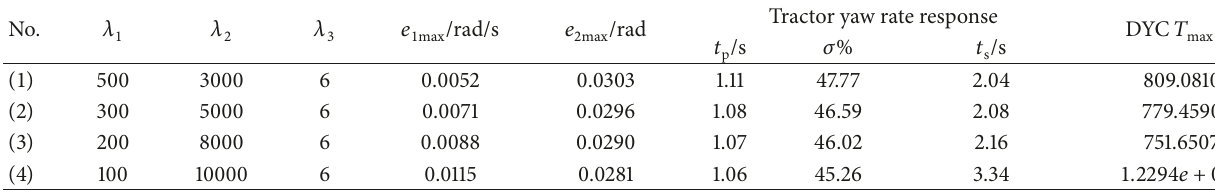
Table 4: Calculated controlled effect parameters and DYC input torques with 4 sets of